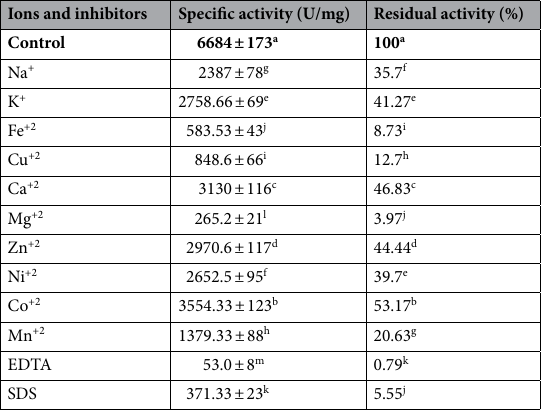
Table 3. Effect of some ions and inhibitors (5 mmol/mL) on pectinase activity produced by C. parasphaerospermum (mean ± SD, n = 3). The results are expressed as the activity in the tested inhibitory conditions compared to the pectinase activity in the control without inhibitors (in bold). At the 0.05 level of probability, means in a column with the same letters are not statistically different. Significant values are in bold.